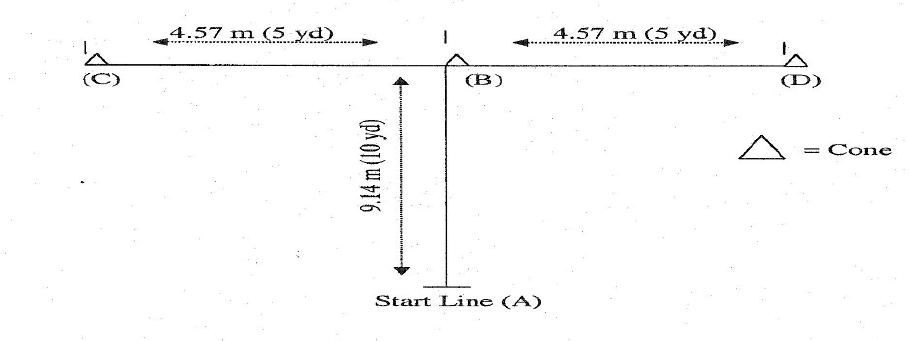
Fig. 1. T test used to measure the